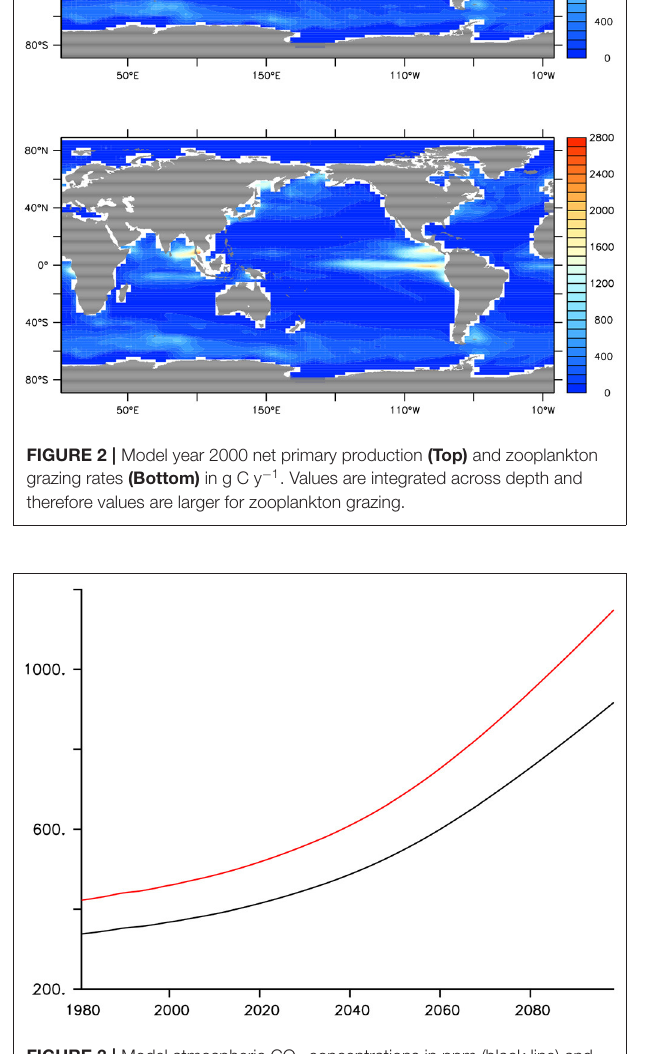
FIGURE 3 | Model atmospheric CO 2 concentrations in ppm (black line) and MP inventory in particles ∗ 10 10 (red line).